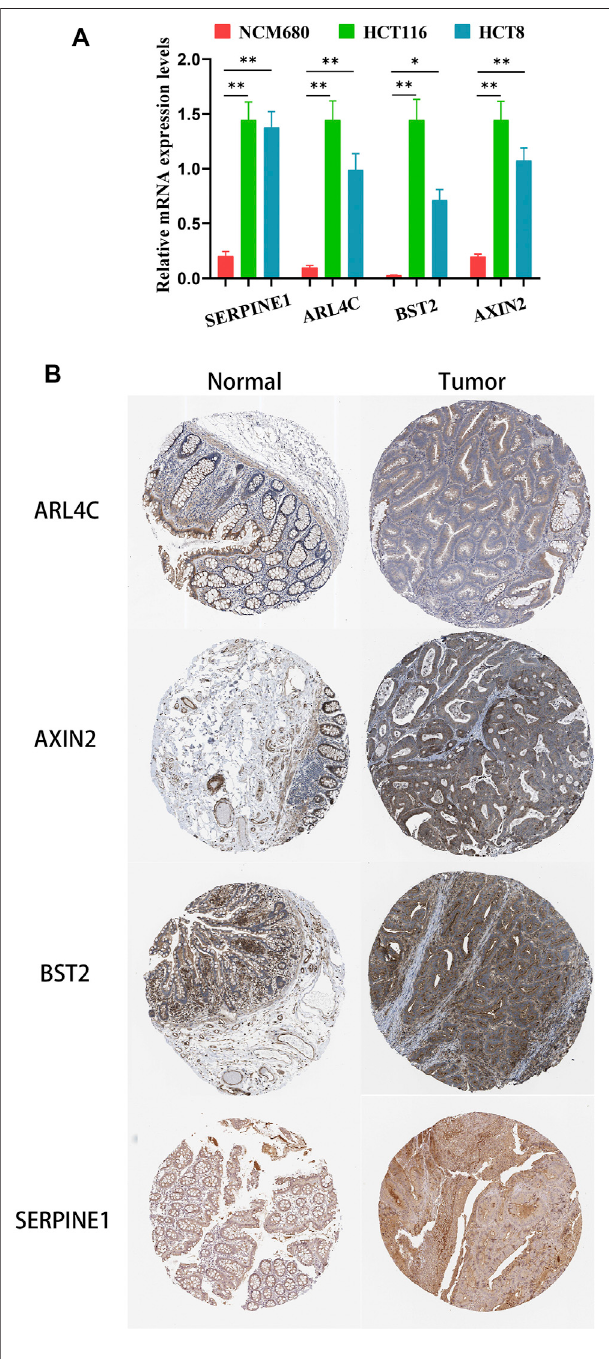
FIGURE8| Theexpressionofthesefourgenesincoloncancercellsand tissues. (A) The relative mRNA levels of the four genes in normal colon epithelial cells (NCM-460) and colon cancer cells (HCT116, HCT8) by qPCR. (B) Representative IHC images of the four genes in colon cancer and normal colon